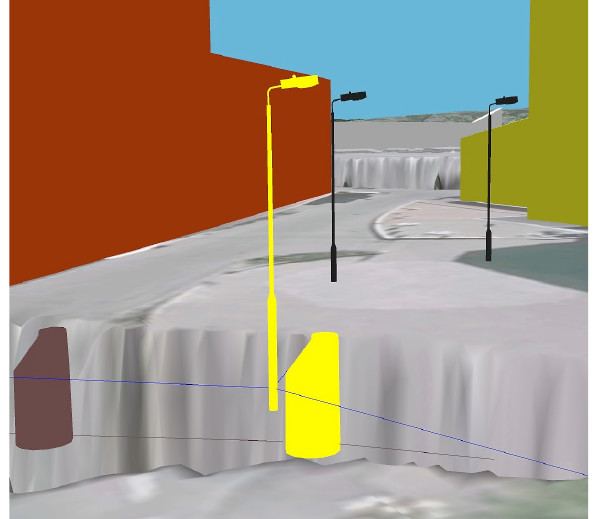
Figure 6. Light pole moves to minimum required distance